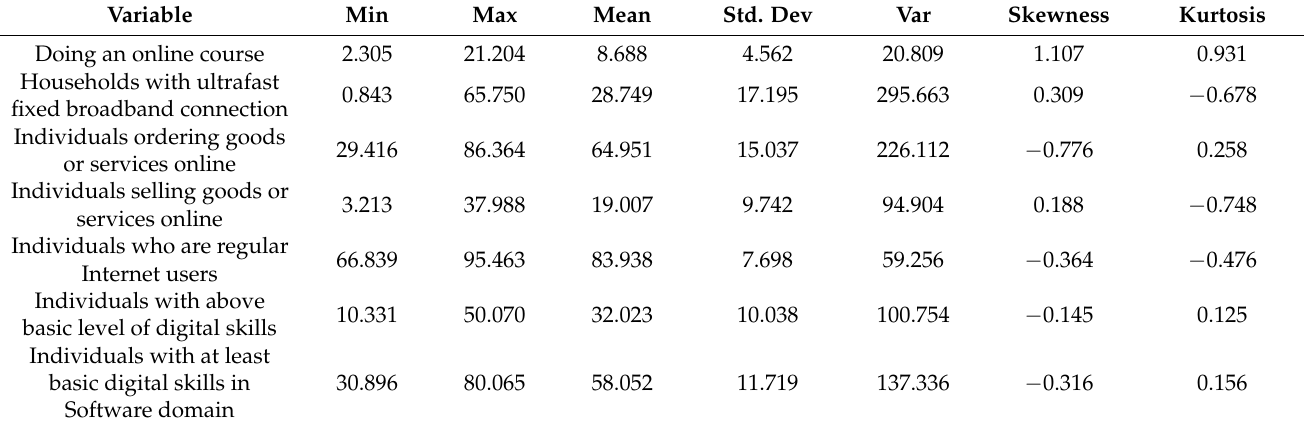
Table 1. Descriptive